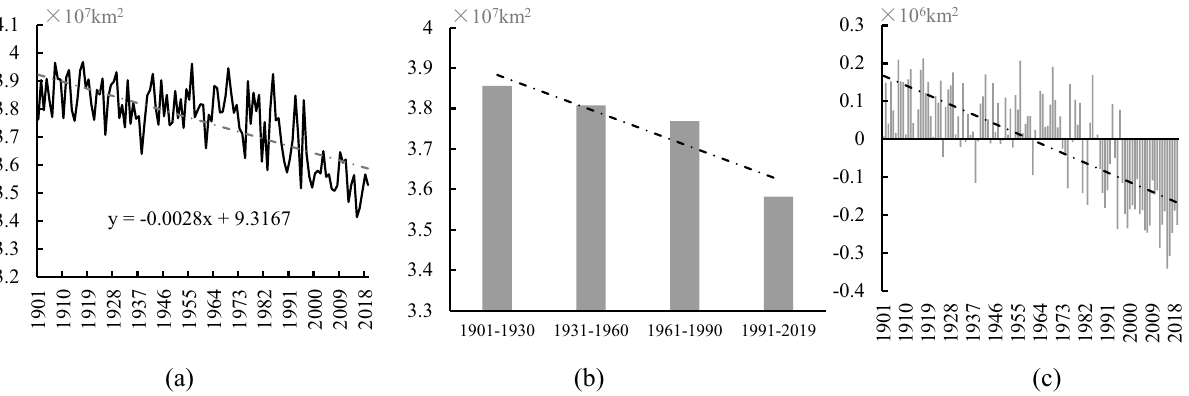
Figure 3. ( a ) Interannual and ( b ) tri-decadal variations and ( c ) anomalies in the spatial extent of the Mid-to- High latitude cold regions of the NH from 1901 to 2019.